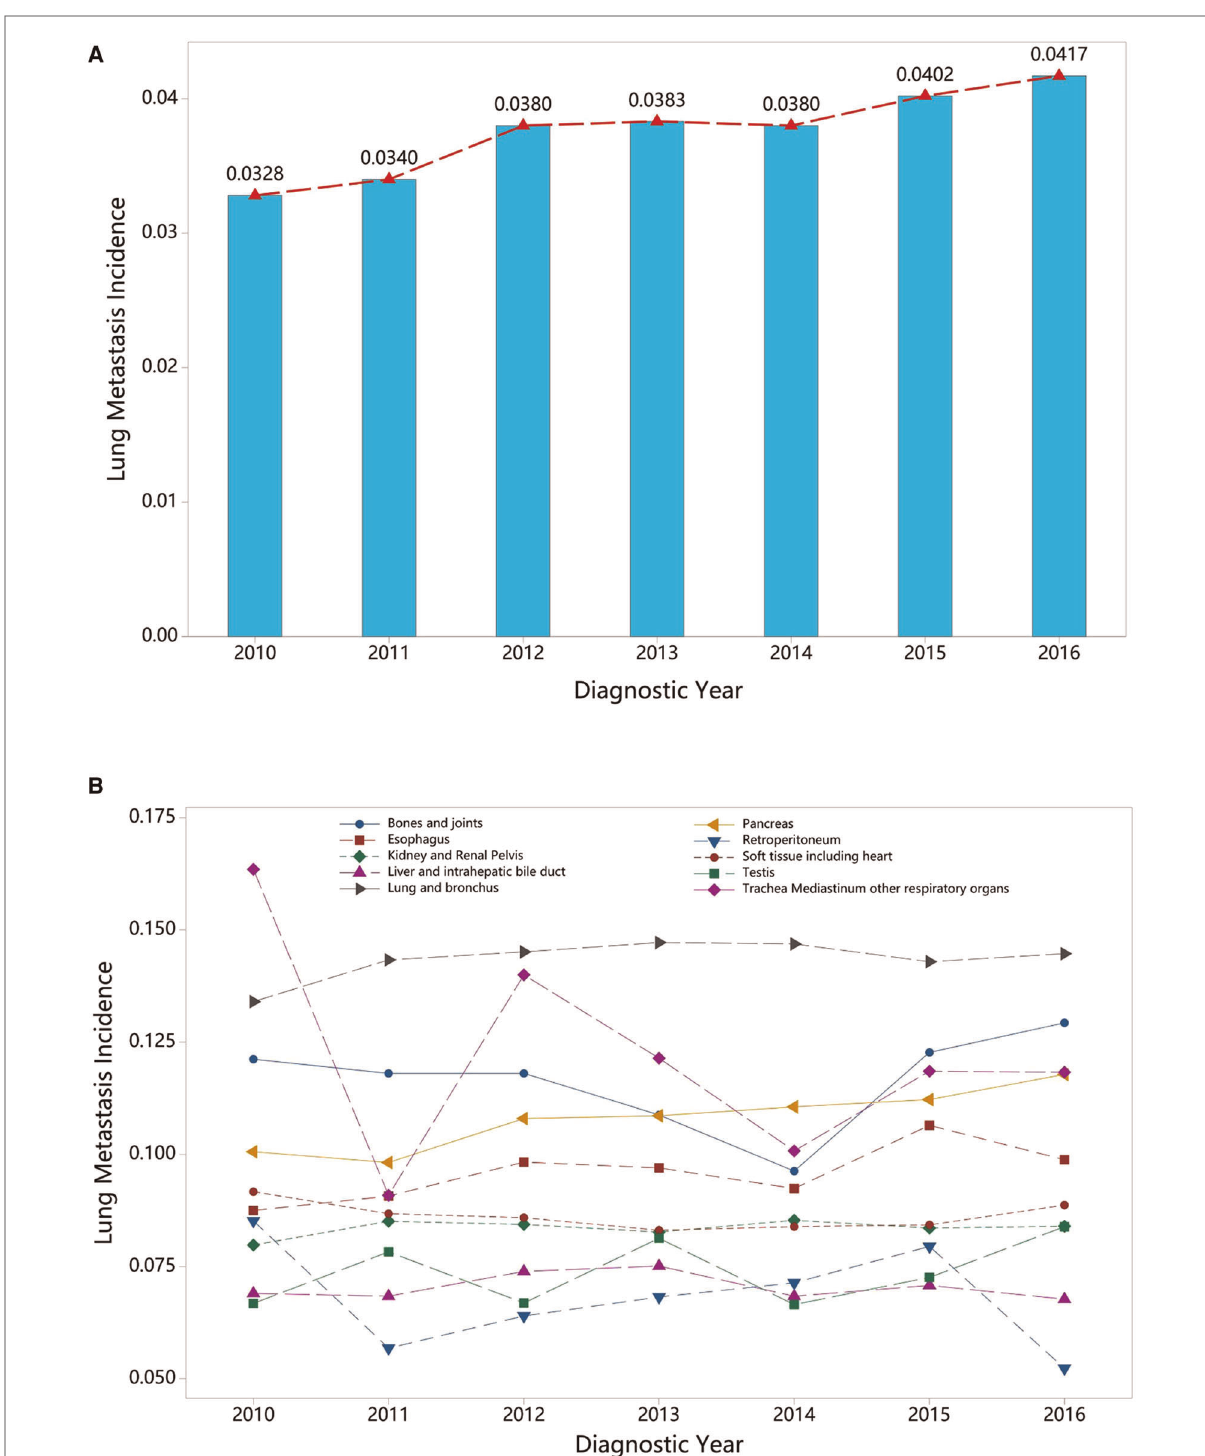
FIGURE 4 Annual variation curve of ( A ) the pooled prevalence of LM from 2010 to 2016 and ( B ) the top ten of pooled prevalence LM across 58 cancer sites (excluding mixed cancer sites and cancers with a sample of less than